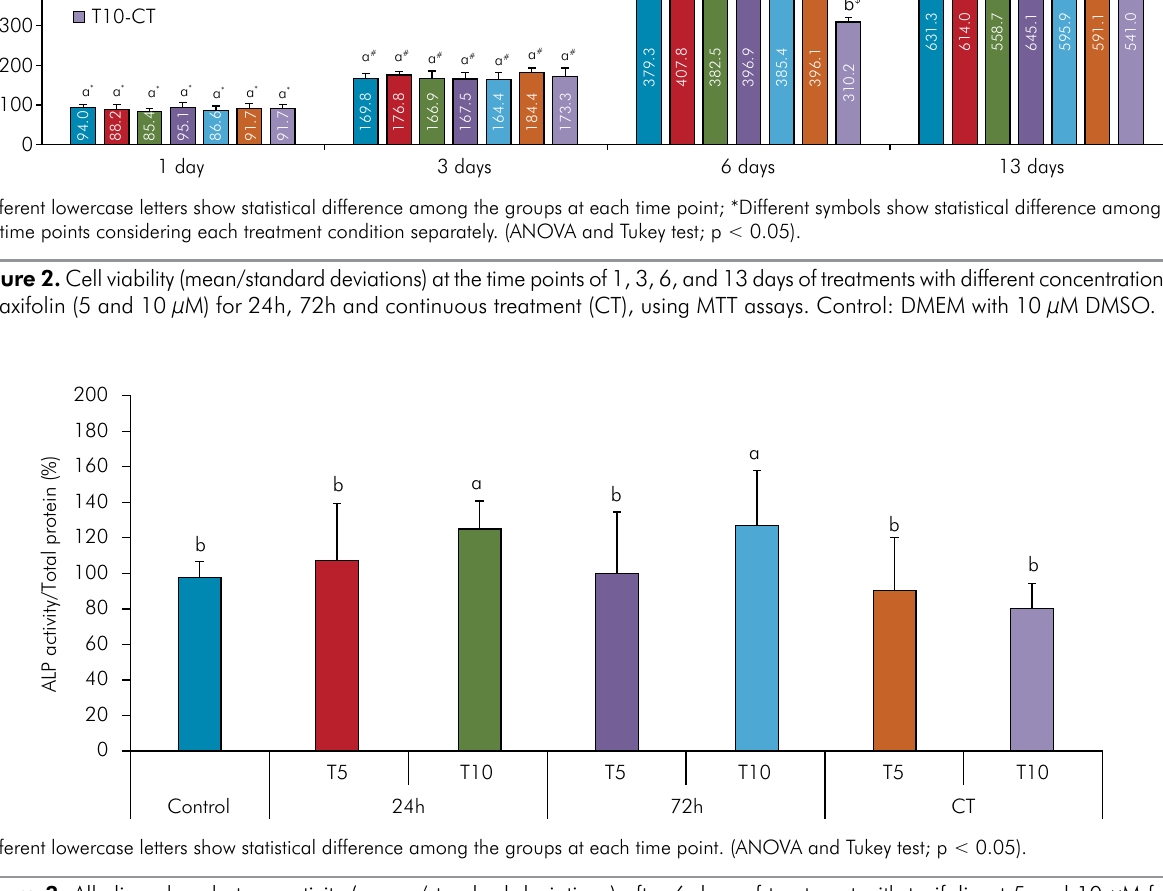
5 Braz. Oral Res.